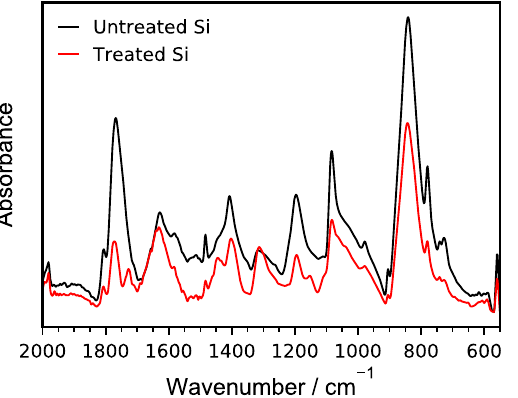
Figure 6. FTIR-ATR spectra of untreated and treated (75 nm PMMA) silicon electrodes that were lithiated to 0.05 V and then delithiated to 1.5 V at C/3 using 1.2 M LiPF 6 in 3:7 EC/DMC electrolyte. Electrodes were rinsed with dimethyl carbonate and dried at 80